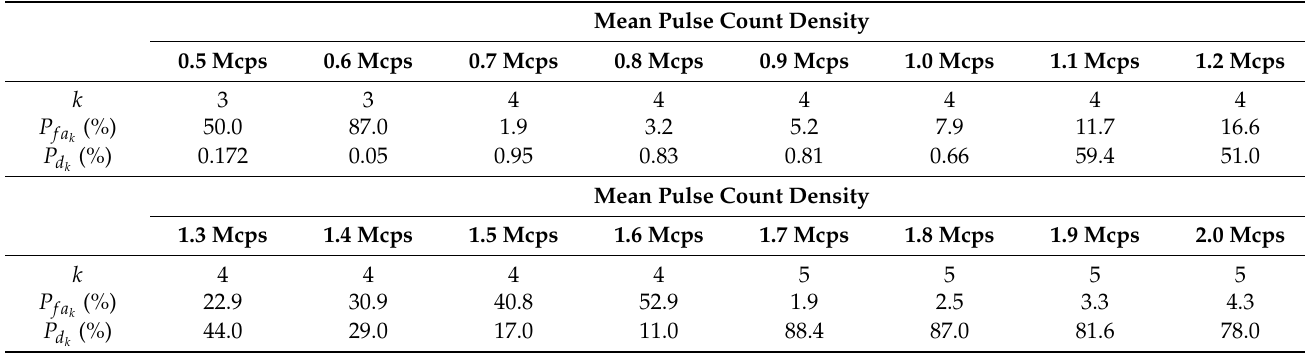
Table 2. Correct ranging probability ( P d ) when the detected signal codes number equals the signal recognition threshold k ( i = k ) and incorrect ranging probability ( P fa ) when the detected noise codes number is equal to or greater than the signal k recognition threshold ( I n ≥ k ) under different mean pulse count